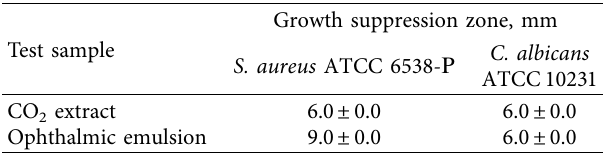
Table 4: Results of antimicrobial activity of the extract and eye drops obtained by serial dilution. Test sample Extract no. 1 Note. The symbol “—” indicates the extract does not have antimicrobial activity and “ ∗ ” indicates the extract has bacteriostatic effect. Table 5: Results of antimicrobial activity of extracts obtained by the diffusion